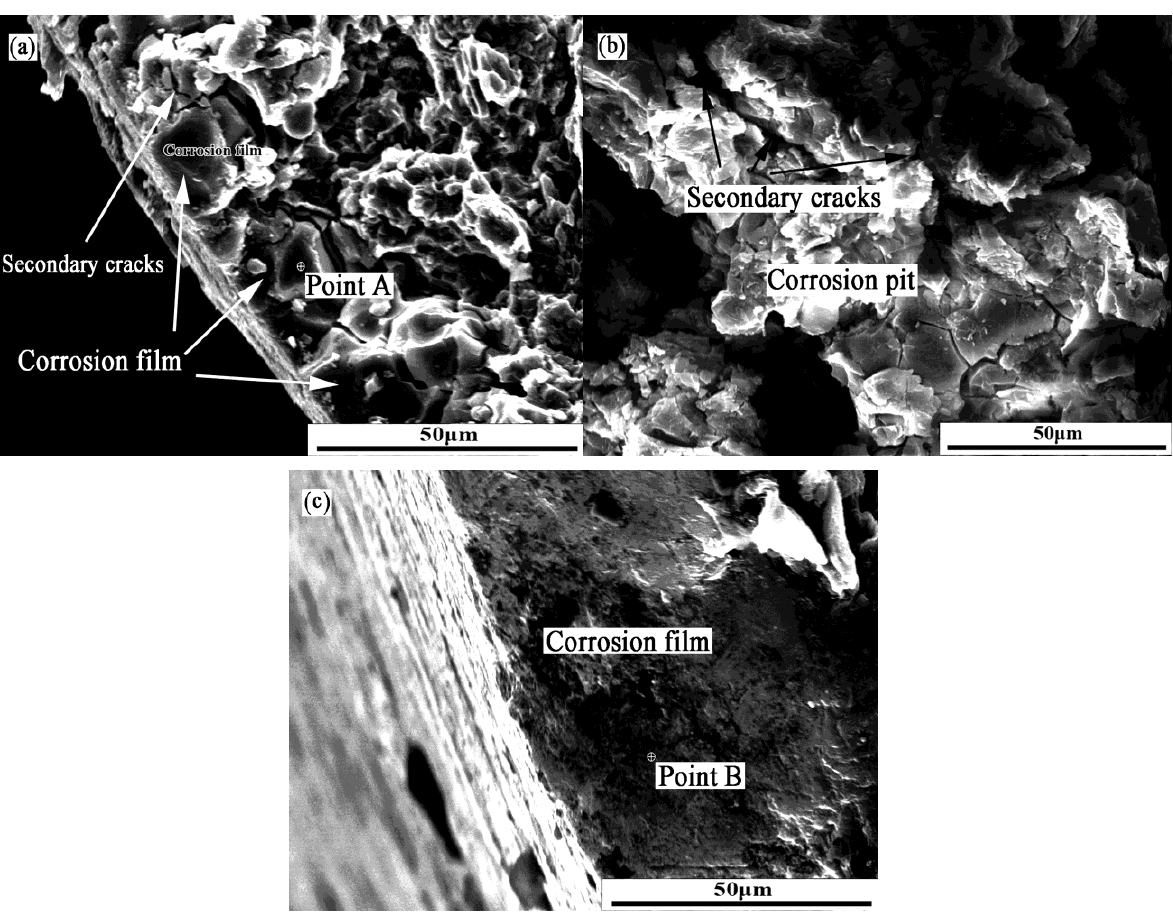
Figure 6. Fractography of test samples: ( a ) tensile fracture of the samples immersed in the sterile corrosion medium; ( b ) tensile fracture of the samples immersed in the SRB corrosion medium; and ( c ) morphology of the tensile fracture with corrosion film in the presence of